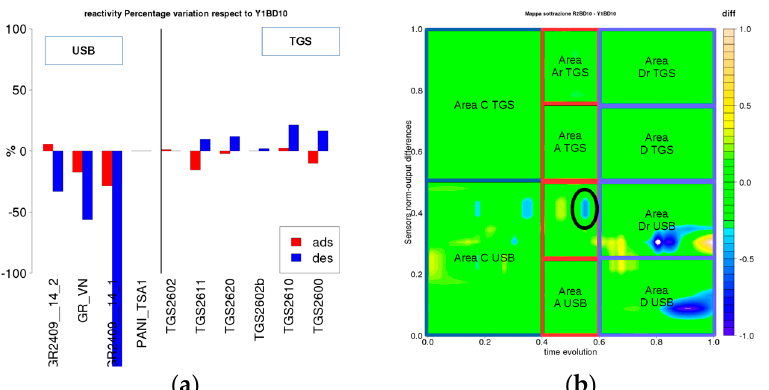
Figure 1. example of e-nose odor pattern comparison between Fatalii and Habanero for freezed samples: ( a ) percentage relative change in the sensors adsorbing and desorbing response max velocity; ( b ) Signal and Signal rate differences among sensors—comparison map. The black circle indicates an area that show discrimination